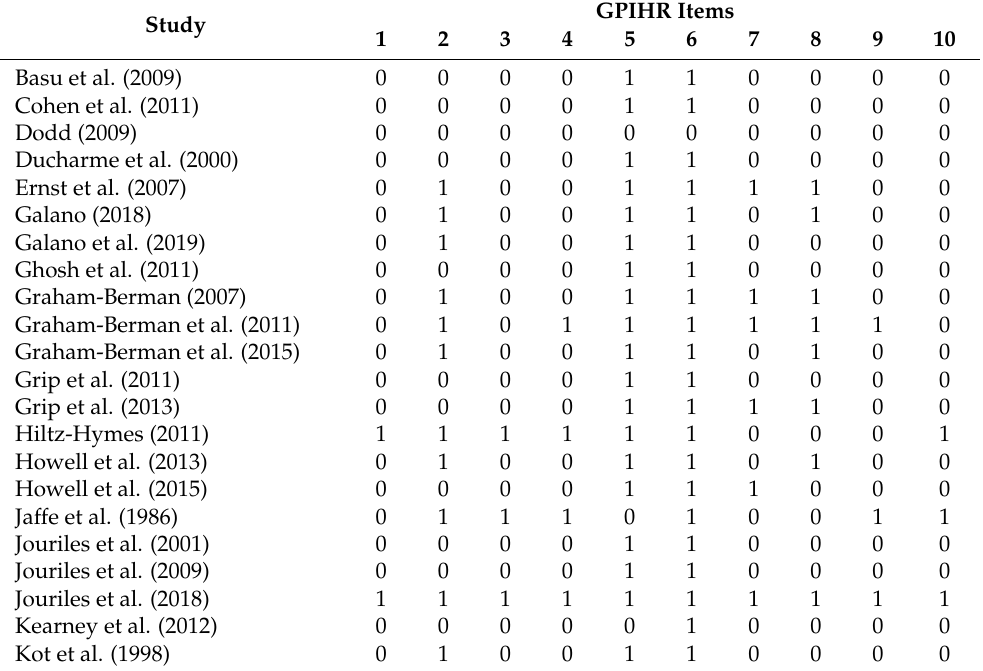
Table A3. Selected Studies and GPIHR